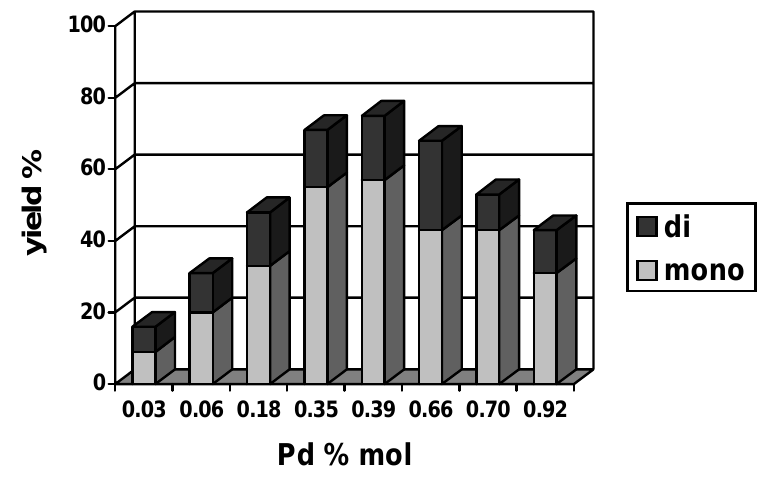
Figure 3. The yield of mono- and diarylated cyclohexenes obtained in the Heck reaction